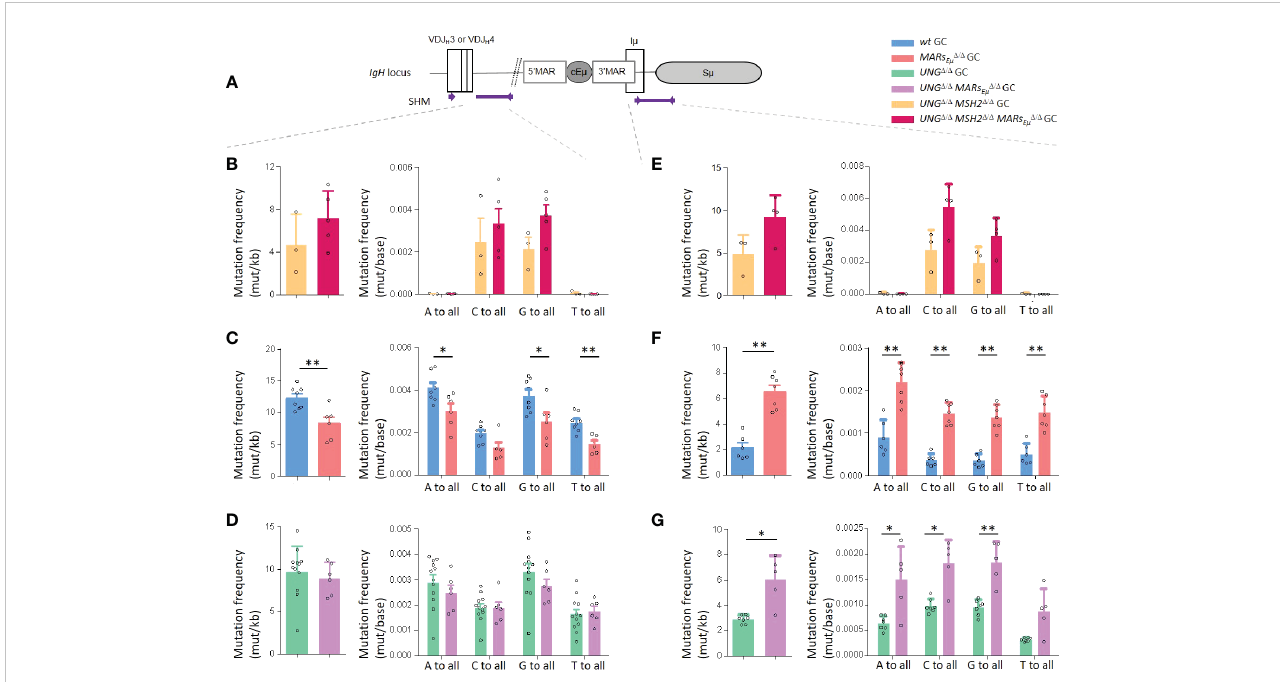
FIGURE 4 MARs Eμ deletion impedes error-prone repair pathways upstream from Eμ region. Comparison of IgH SHM events occurring on both sides of cEμ in Peyer ’ s patch GC B cells sorted from wt and MARs Eμ D / D mice models, bred in genetic backgrounds de fi cient for base excision repair ( Ung KO) and mismatch repair ( Msh2 KO). Data were obtained by NGS (Ion Proton) combined to DeMinEr fi ltering (28). In each region, analyzed and represented as a panel, bar graphs report overall mutation frequencies (left) and detailed mutation frequencies at all bases (right). (A) Location of IgH regions (thick purple lines) tested for SHM, arrows represent primers used for PCR ampli fi cation. (B) SHM downstream from J H 4 in double-de fi cient Ung D / D Msh2 D / D background. (C) SHM downstream from J H 4 in DNA repair pro fi cient ( Ung +/+ Msh2 +/+ ) background. (D) SHM downstream from J H 4 in Ung D / D background. (E) SHM downstream from cEμ in double-de fi cient Ung D / D Msh2 D / D background. (F) SHM downstream from cEμ in DNA repair pro fi cient ( Ung +/+ Msh2 +/+ ) background. (G) SHM downstream from cEμ in Ung D / D background. p-value was determined with two tailed Mann Whitney test; signi fi cant differences are indicated by: *P < 0.05; **P<0.01 and error bars represent SEM of two to three independent